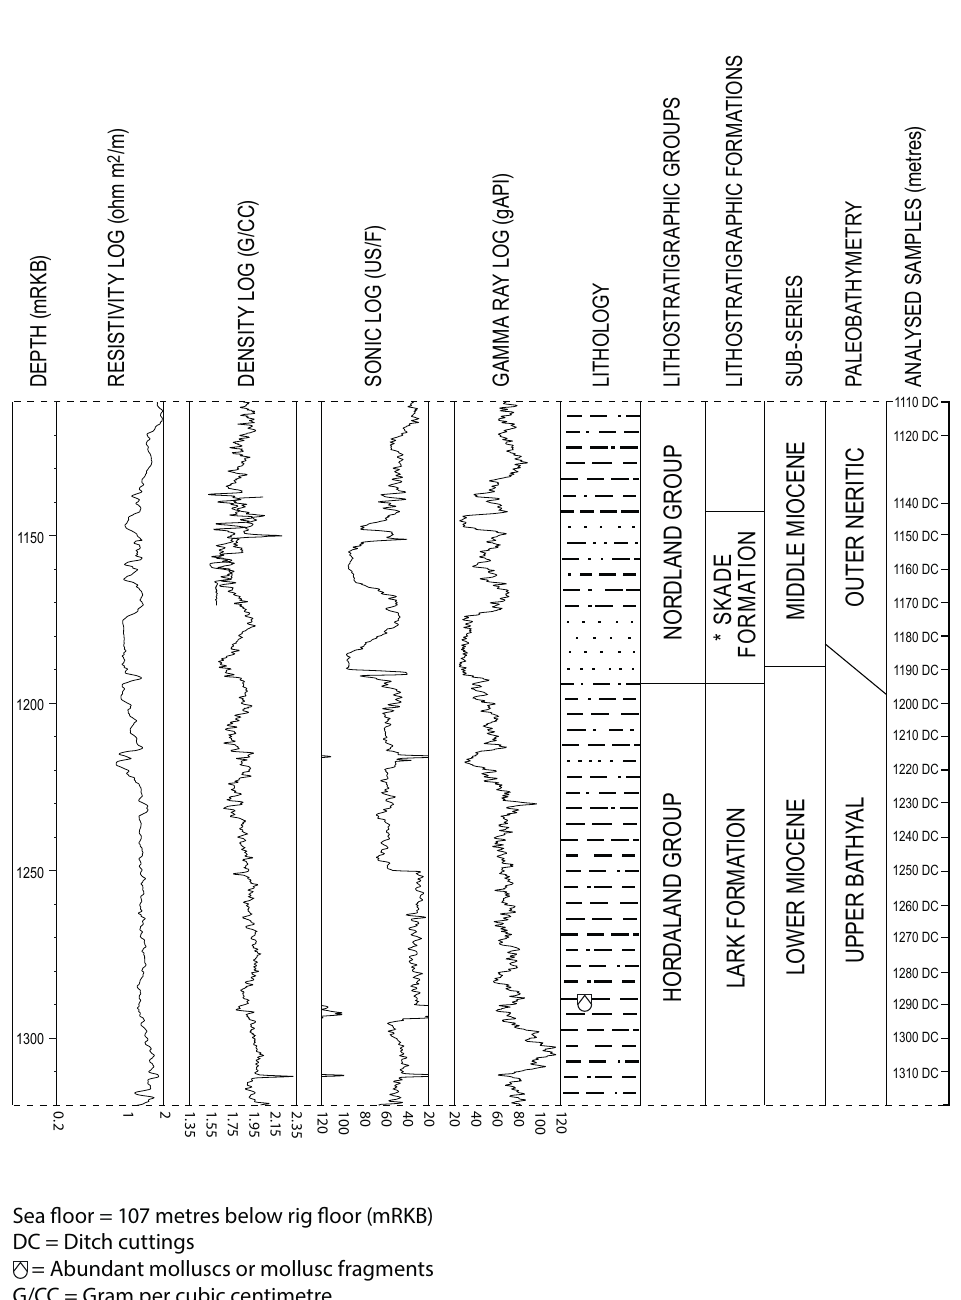
Figure 43. Well summary figure including resistivity log, density log, sonic log, gamma-ray log, lithology, litho- stratigraphic units, sub-series, paleobathymetry and analysed samples for the middle part of the investigated sequence in well 15/9–13 (lower to middle Miocene) including the reference section for the Skade Formation according to Isaksen & Tonstad (1989) (modified after Eidvin et al., 2013d). * According to Eidvin & Rundberg (2007) and Eidvin et al. (2013d) is this unit younger than the Skade Formation in other wells we have investigated and of the same age as the new Eir